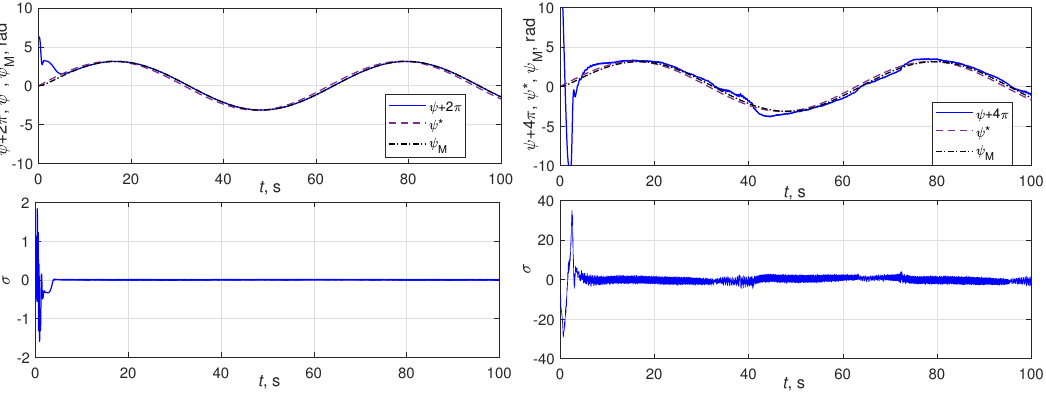
Figure 10. Simulation ( left column ) and experiment ( right column ). ψ ( t ) , ψ ∗ ( t ) , ψ M ( t ) ( upper plot ) and IMR discrepancy signal σ ( t ) ( lower plot ) time histories for ψ ∗ = π sin ( 0.1 t ) . Sine-modification.